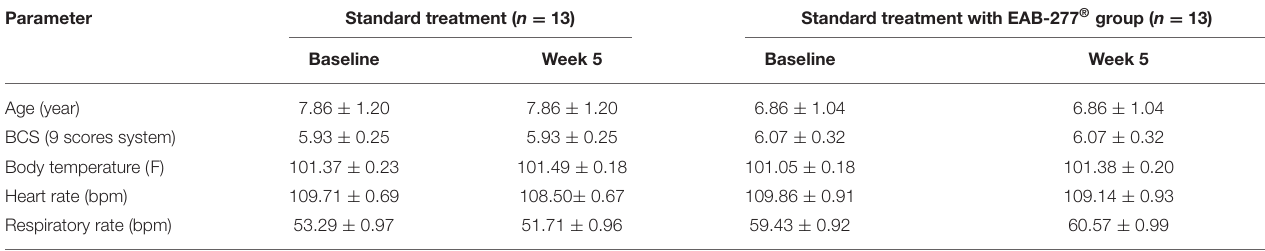
TABLE 2 | Representative general information and physical examination parameters in tracheal collapse dogs.